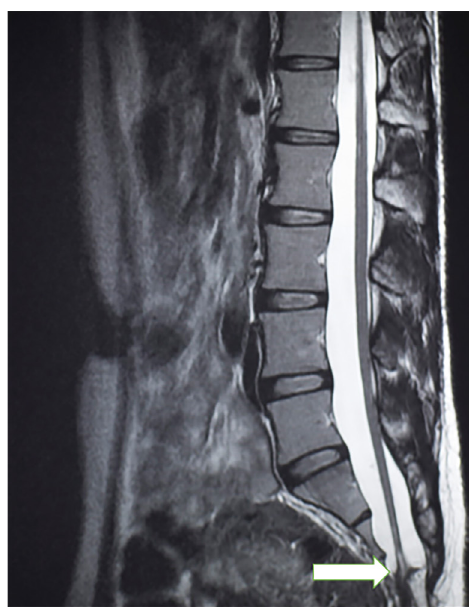
Image 1. Sagittal view of a T2-weighted magnetic resonance image of the lumbar spine showing the conus medullaris of the tethered cord reaching to inferior edge of the second sacral vertebrae